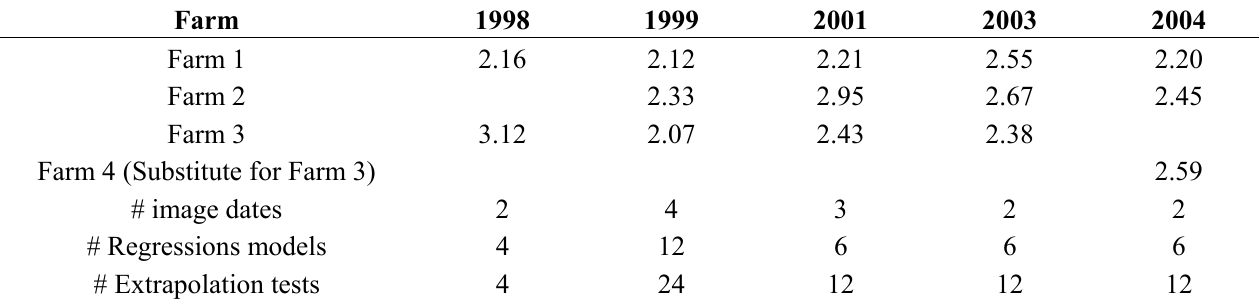
Table 3. Availability of yield mapping data by farm and average farm wheat yield (t/ha), the number of image dates, number of regression models and extrapolation